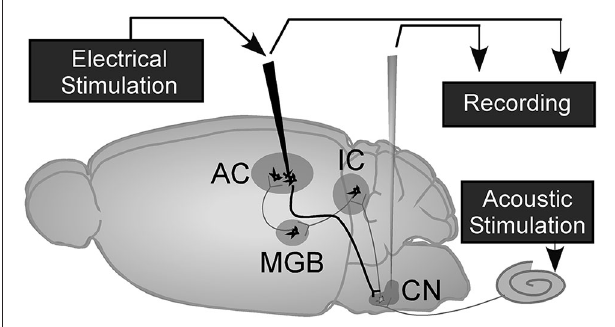
FIGURE 1 | A schematic of the mouse brain with recording and electrical stimulation sites (adapted from Luo et al., 2008) . The corticofugal projection to DCN is indicated by a solid dark line. Auditory cortex, AC; medial geniculate body, MGB; inferior colliculus, IC; cochlear nucleus,